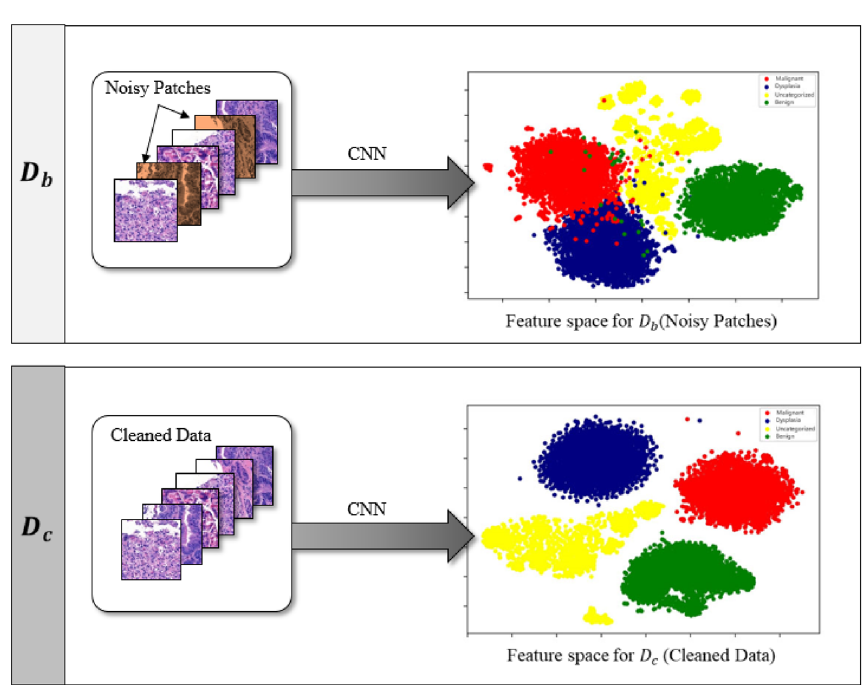
Figure 10. Feature space visualization for DenseNet-201 features using t -SNE dimensionality reduction based on baseline and cleaned data. The red, blue, yellow, and green colors denote the, malignant, dysplastic, uncategorized and benign classes,